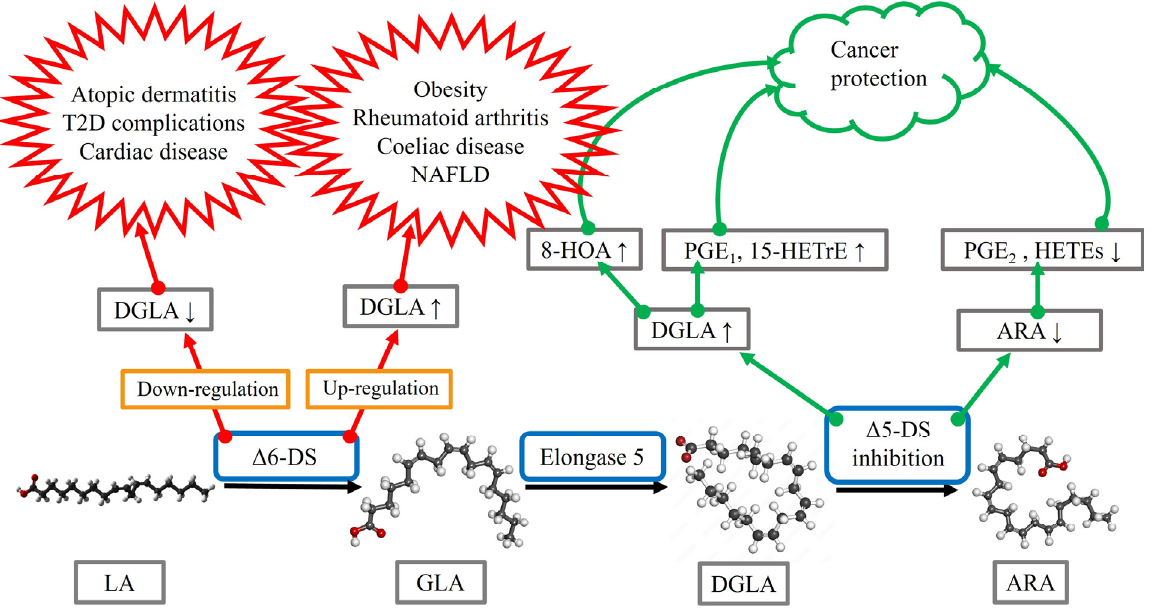
Figure 2. A summary of the potential benefits and hazards of desaturase manipulation based on the current literature review. ARA = arachidonic acid, DGLA = dihomo- γ -linolenic acid, DS = desaturase, GLA = γ -linolenic acid, HETE = hydroxyeicosatetraenoic acid, 15-HETrE = 15-(S)-hydroxy-8,11,13-eicosatrienoic acid, 8-HOA = 8-hydroxyoctanoic acid, LA = linoleic acid, NAFLD = non-alcoholic fatty liver disease, PG = prostaglandin. Open-source images provided by Creative Commons and Adobe Stock (https://upload.wikimedia.org/wikipedia/commons/a/a8/Linoleic-acid-from-xtal-1979-3D-balls.png;